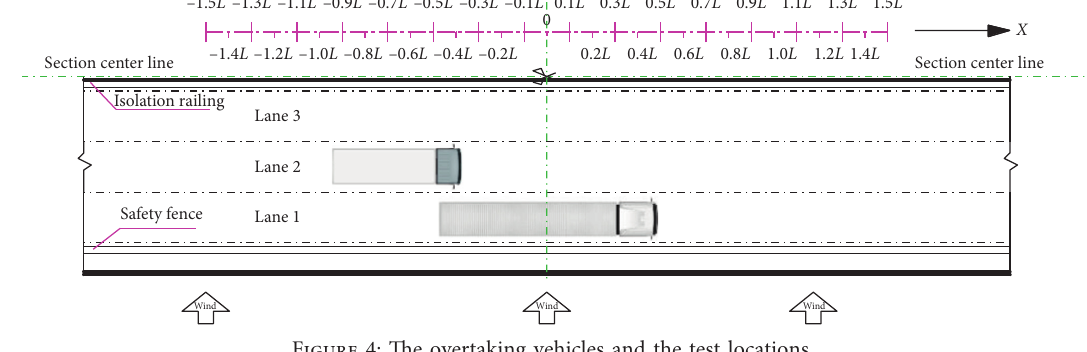
Figure 4: The overtaking vehicles and the test